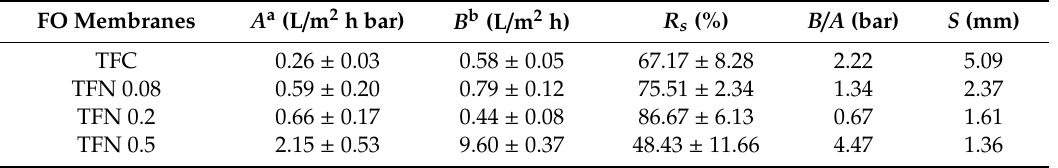
Table 2. The intrinsic transport properties of TFC and TFN